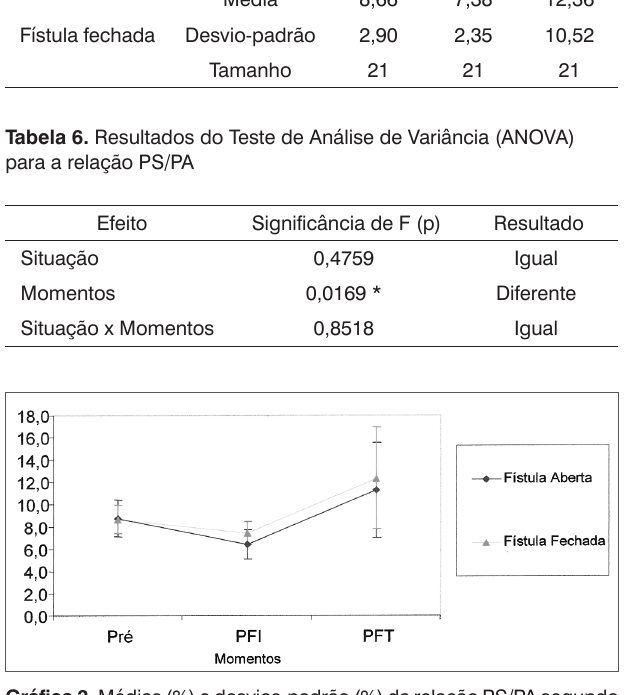
numericamente. A Tabela 9 mostra os valores obtidos para a média, desvio-padrão e tamanho da amostra estudada dos grupos nos diferentes momentos do experimento.